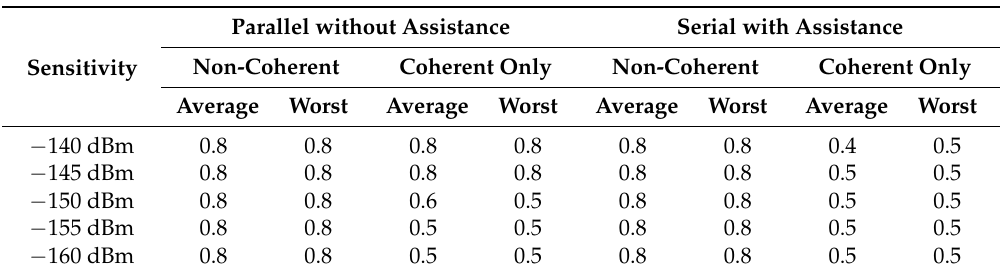
Table 21. Ratio of number of frequency bins between the E5 and E1